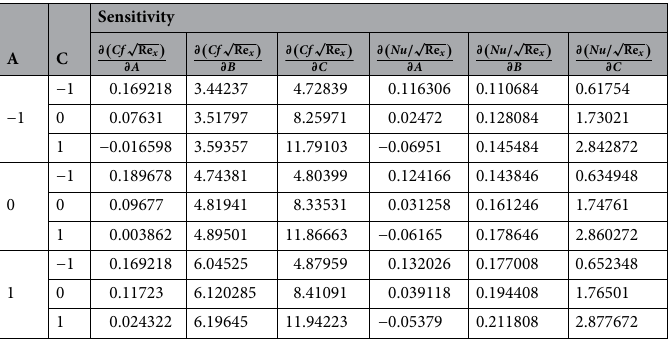
Table 7. Sensitivity analysis of Cf √ Re x and Nu / √ Re x with B = 0 and all A and C